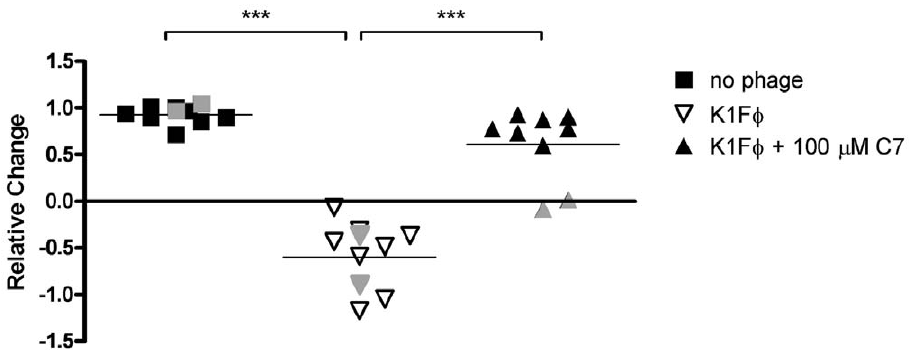
Figure 6. C7 is active against other clinical K1 UPEC strains. A panel of K1F phage sensitive clinical E. coli strains was tested for phage sensitivity in the presence or absence of 100 m M C7. Strains were grown in 1% DMSO or C7 and infected with K1F phage where indicated. Relative OD 600 change after 3 hrs post infection (normalized to the growth of UPEC strain UTI89) is shown. Addition of 100 m M C7 inhibits lysis of tested clinical strains. P value: , 0.0001 no C7 (phage only) compared to C7 treatment. Arrow indicates two clinical strains in which C7 only partially restored growth.